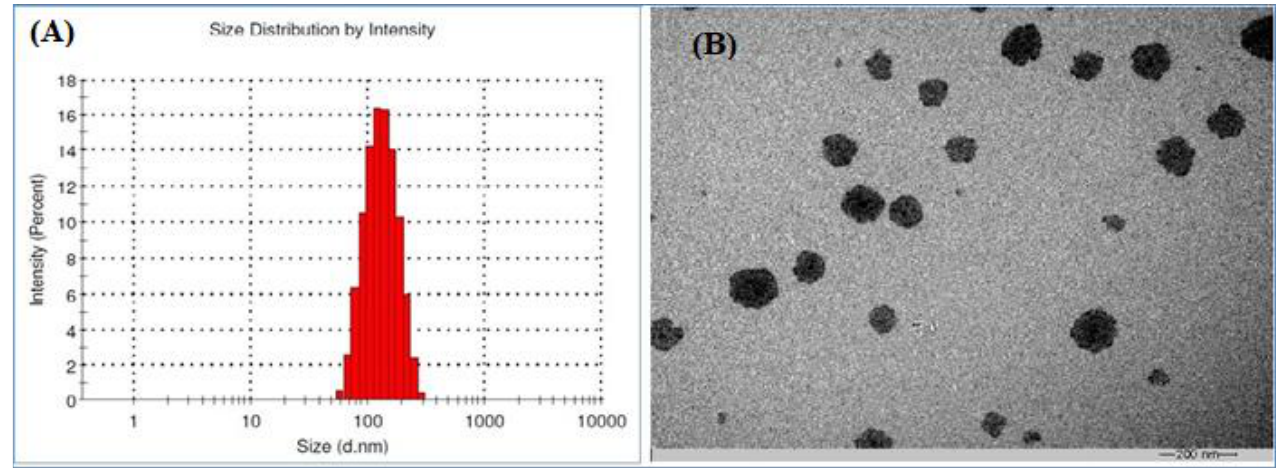
Figure 5. ( A ) Particle size and ( B ) TEM micrograph of optimized APG-PEGylated CNPs formulations.